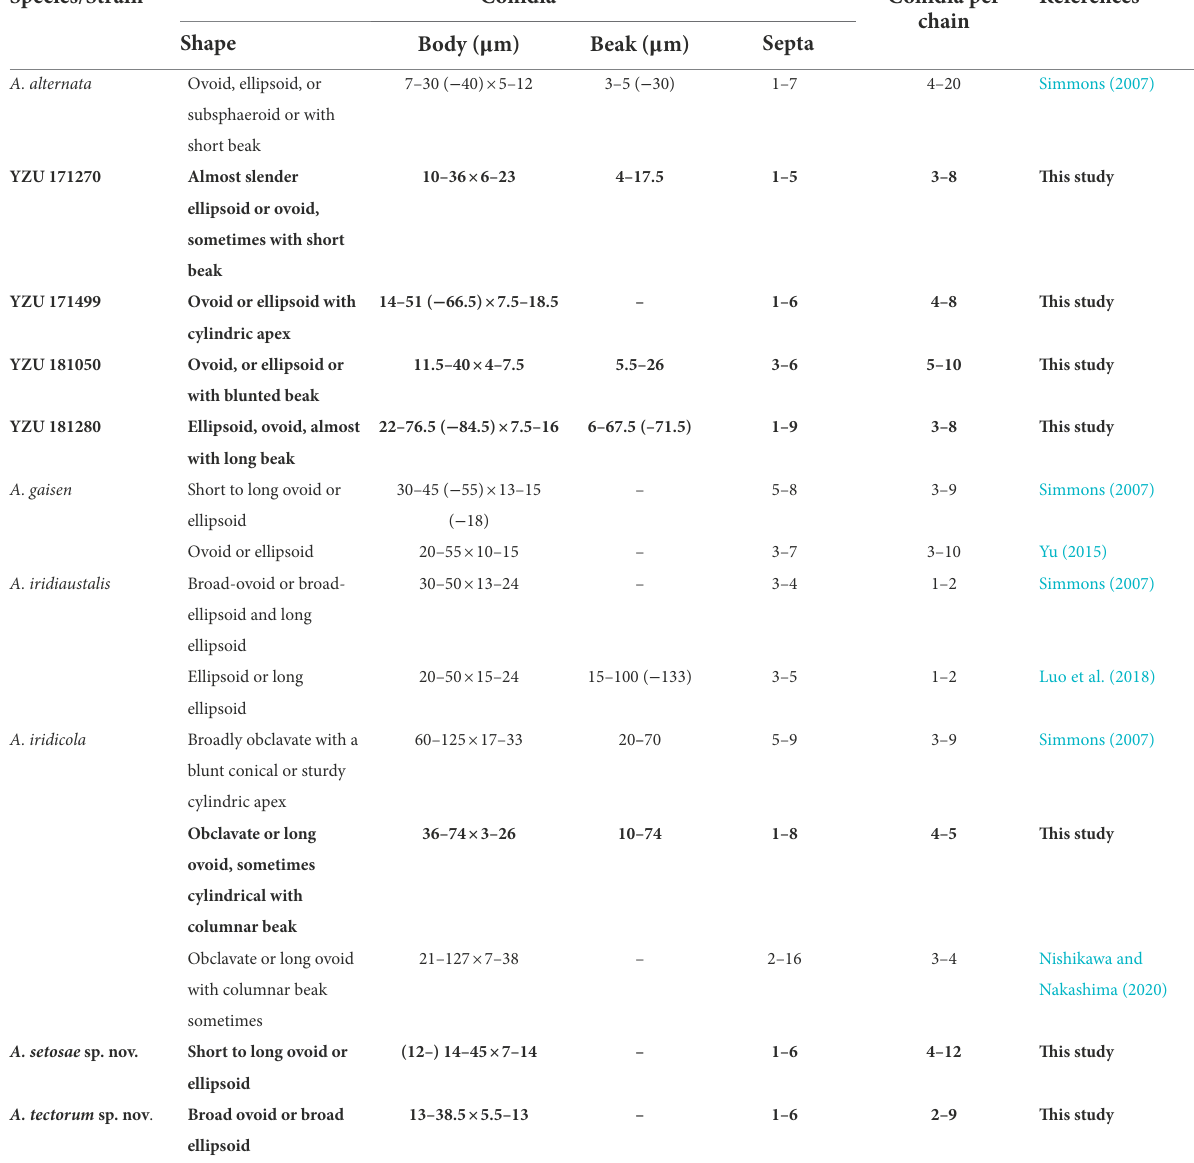
TABLE 3 Morphological comparison of the present Alternaria and their relevant